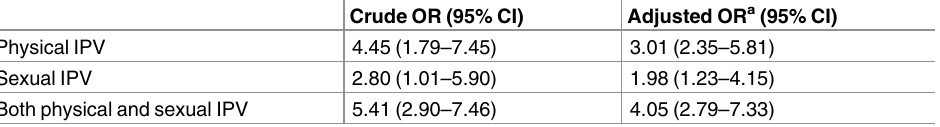
Table 2. Logistic regression analysis to predict the association between maternal lifetime experience of IPV and low birth weight (n = 400).